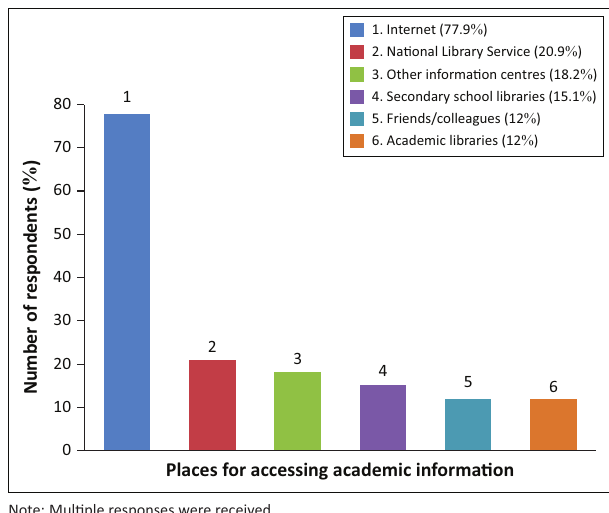
FIGURE 5: Places and ways of accessing academic information ( n =